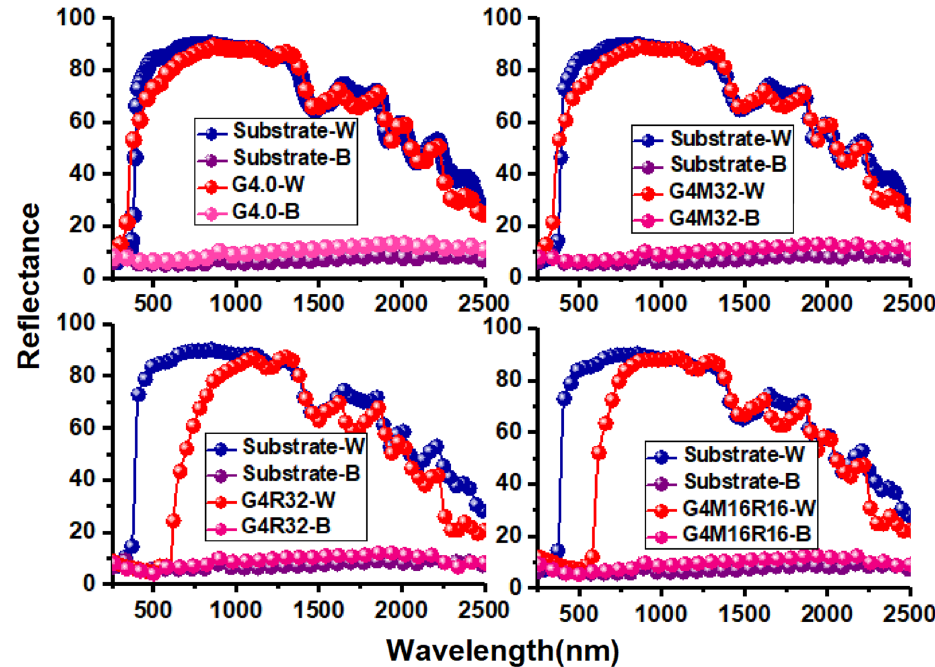
Figure 6. Reflection spectra of hybrid dendrimers.